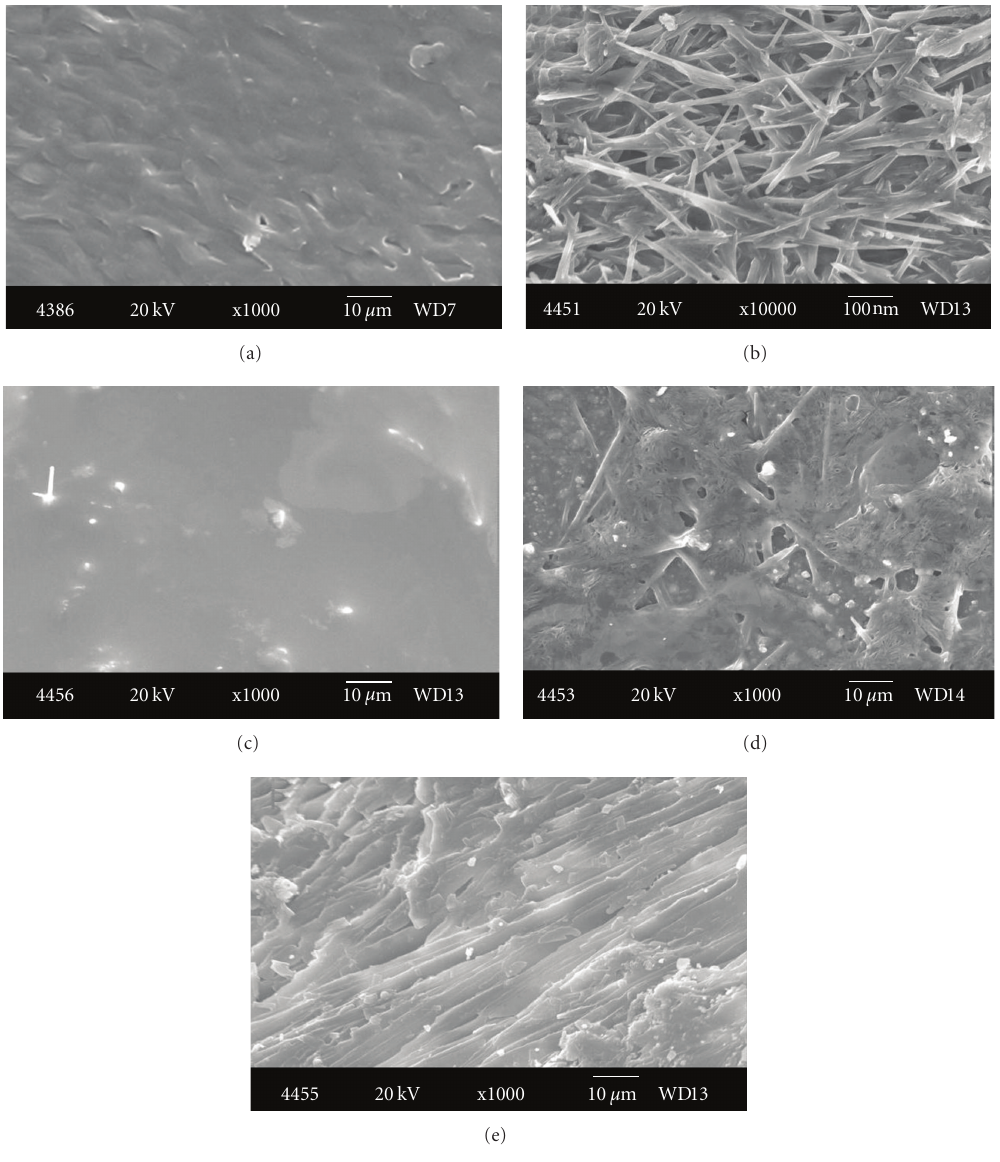
Figure 8: SEM photographs of (a) GCE surface, (b) Nano RF/GCE, (c) AAP accumulated RF/GCE, (d) ASA accumulated RF/GCE, (e) DP accumulated